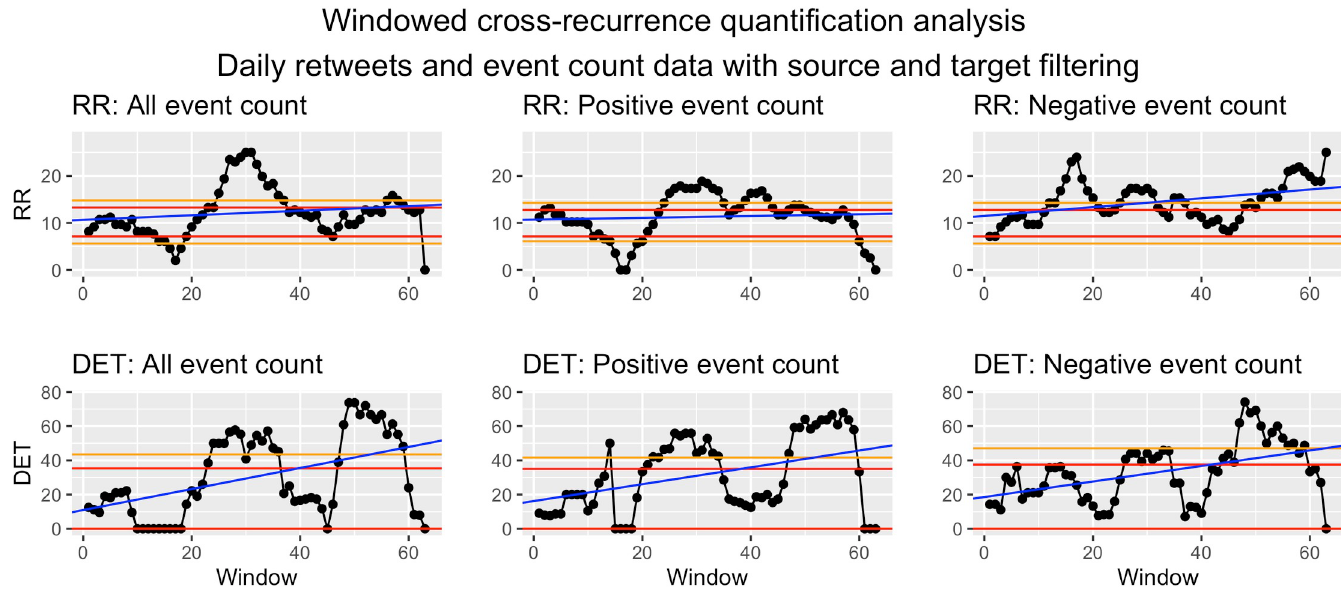
Fig 16. Windowed CRQA for daily retweets and event counts from source-target filtered data.